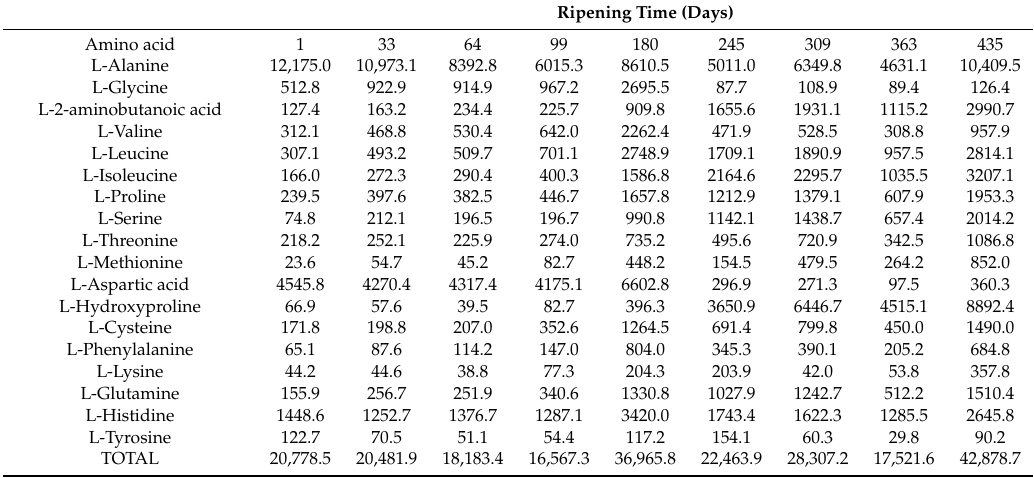
Ripening Time (Days)